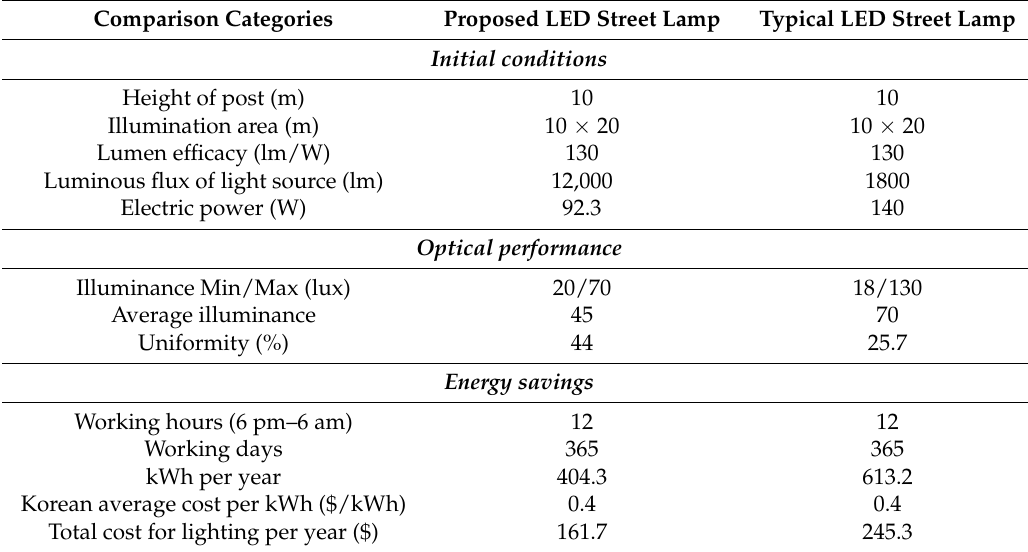
Table 3. Comparison between our proposed LED street lamp and a typical LED street